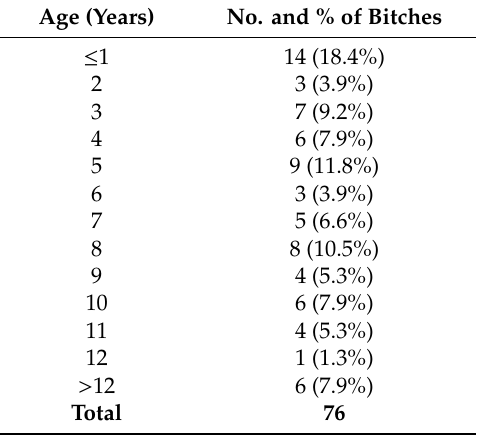
Table 1. Age distribution in numbers and percentage of bitches presented with dystocia after unwanted mating ( n = 76).